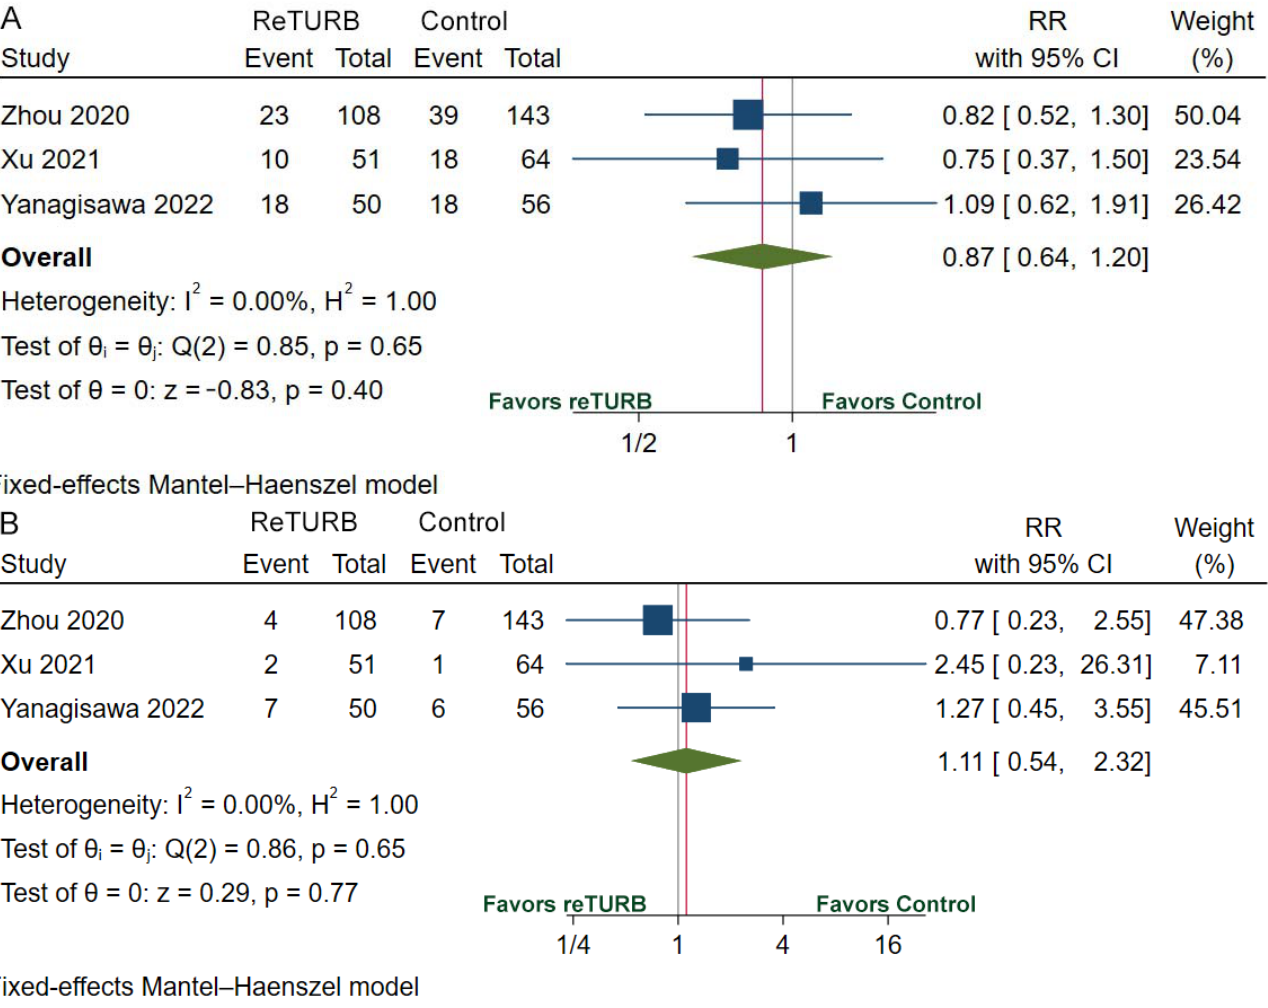
Figure 4. Forests plots of comparisons of recurrence ( A ) and progression ( B ) risk between the reTURB group and control group [32,36,38]. The gray lines represent the reference lines and the red lines show the pooled effect sizes. CI: confidence interval. RR: relative risk; reTURB: repeat transurethral resection of bladder tumors.